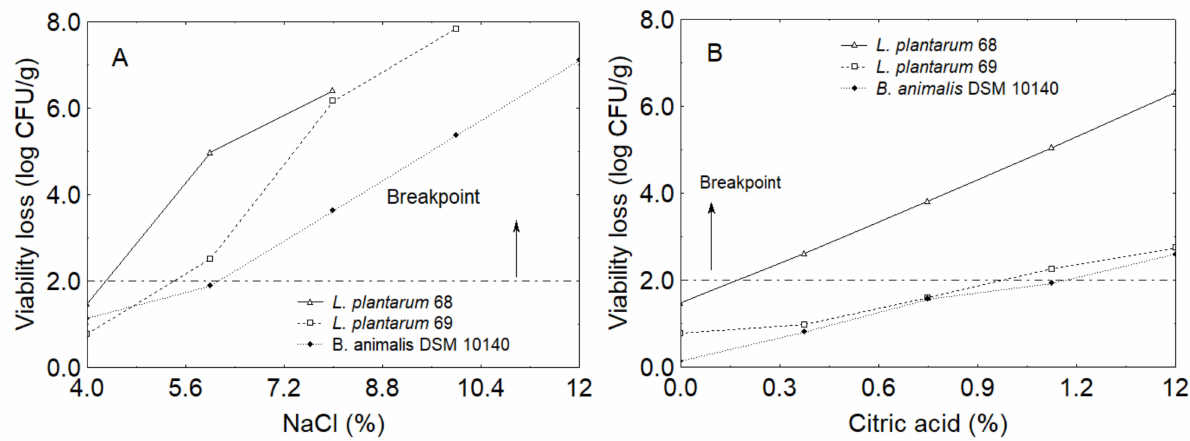
Figure 5. Prediction profiles: individual effect of NaCl ( A ) and citric acid ( B ) on the viability loss of B. animalis subsp. lactis DSM 10140, L. plantarum 68, and L. plantarum 69 in the model system (agar dishes).